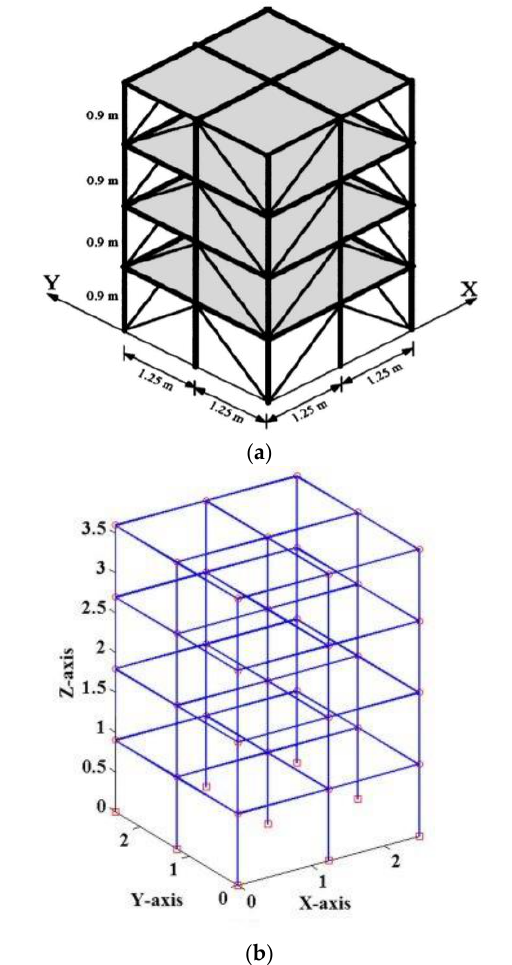
Figure 8. The IASC–ASCE SHM benchmark 4-story building model: ( a ) the original model, and ( b ) the developed model.